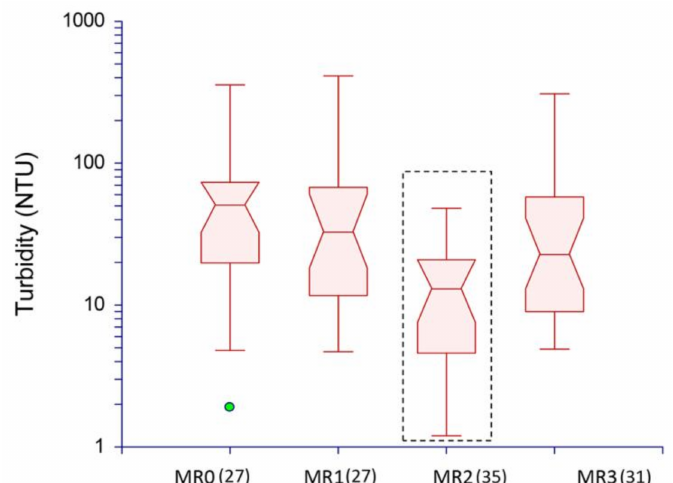
Figure 8. Turbidity response at Mill Run by logger. The turbidity response for each logger was plotted and analyzed with ANOVA. Logger MR 2 was found to have a statistically different from loggers MR 1 and MR 2. Numbers in parentheses indicate the number of storms included in the